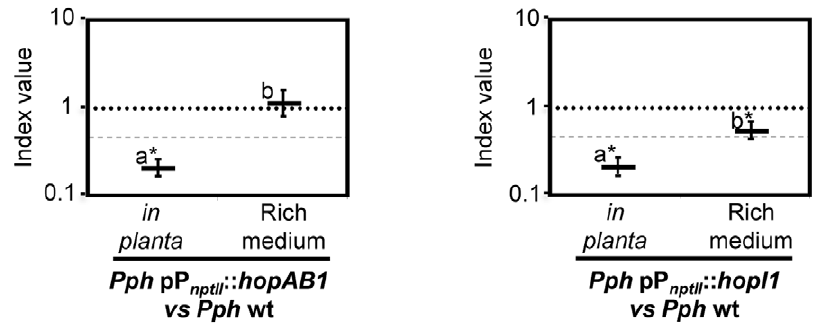
Figure 5. Effect on bacterial growth of overexpressing HopAB1 and HopI1. Wild type strain Pph 1448a carrying plasmids expressing either of these effectors from the strong nptII promoter were co-inoculated with the wild type strain. Competitive index was analyzed either in bean leaves (at 7 dpi) or in rich medium (LB medium, at 24 hours post-inoculation). Competitive indices are the average of three replicates per experiment. A dashed line corresponding to a CI=0.5 is included for reference. Error bars represent the standard error. Asterisks indicate results significantly different from one, as established by Student’s t-test (P , 0.05). Mean values marked with the same letter (a or b) indicate results not significantly different from each other, as established by One Way ANOVA and Holm-Sidak test for multiple comparison or One Way ANOVA on Ranks and Tukey test for multiple comparison when Equal Variance Test failed ( P , 0.05).